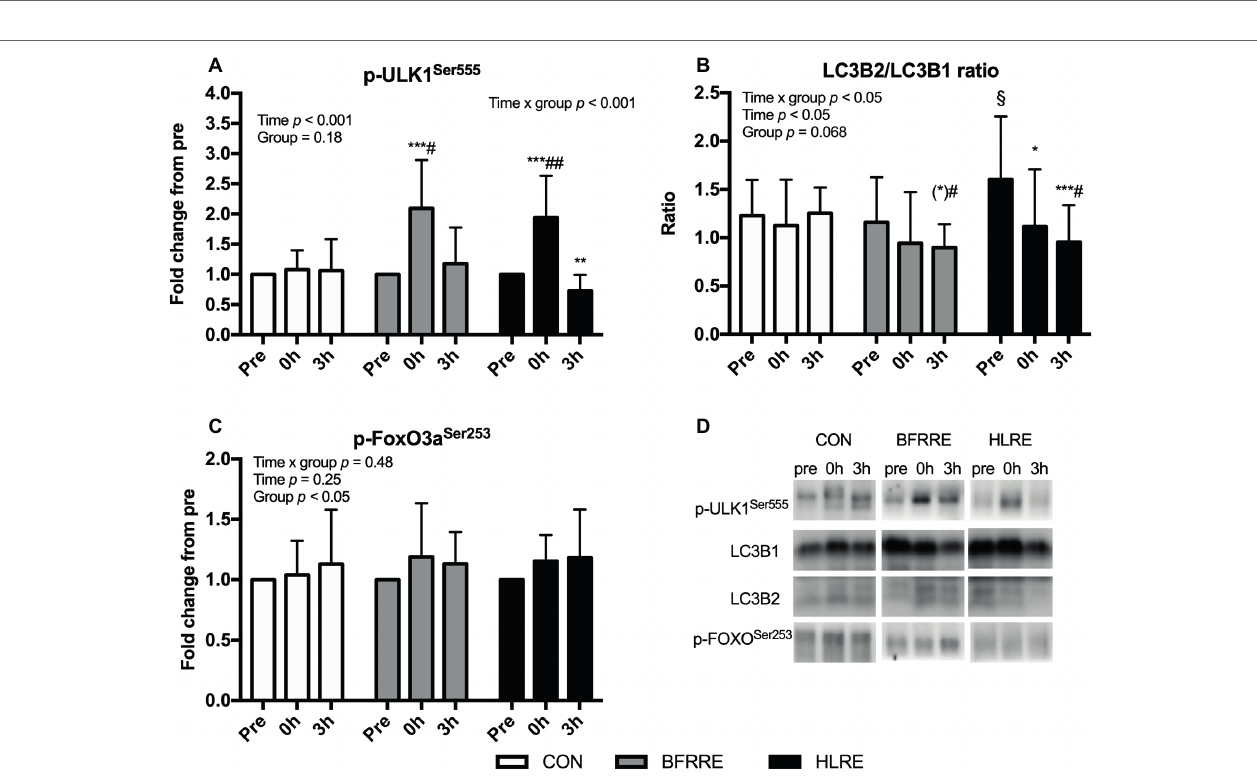
FIGURE 5 | Phosphorylation of ULK1 at Ser 555 (A) , the ratio of LC3B2 to LC3B1 (B) protein expression, and (C) phosphorylation of FoxO3a at Ser 253 immediately (0 h) and 3 h (3 h) after acute exercise. Data are presented as mean ± SD. Overall effects are given in the upper left corner of graphs. * p < 0.05, ** p < 0.01, and *** p < 0.001 different from pre within group; (*) p < 0.1 tendency toward difference from pre within group; § p < 0.05 different from BFRRE within time-point; # p < 0.05 and ## p < 0.01 different from CON within time-point. Representative blots are shown in (D)